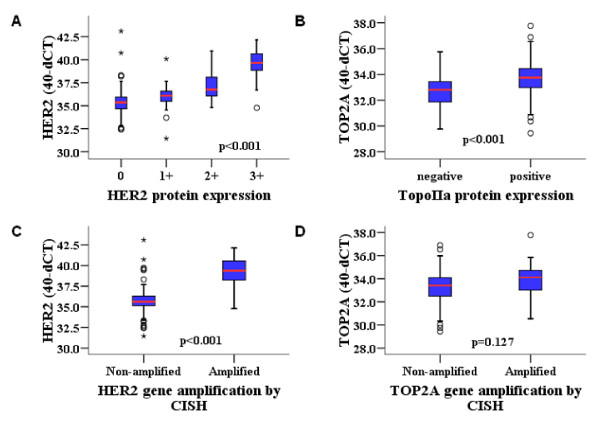
Association of HER2 and TOP2A relative mRNA expression (40-dCT values) with corresponding protein expression by IHC (A, B) and gene amplification by CISH (C, D). Comparisons were made using Kruskal Wallis and Mann-Whitney tests.